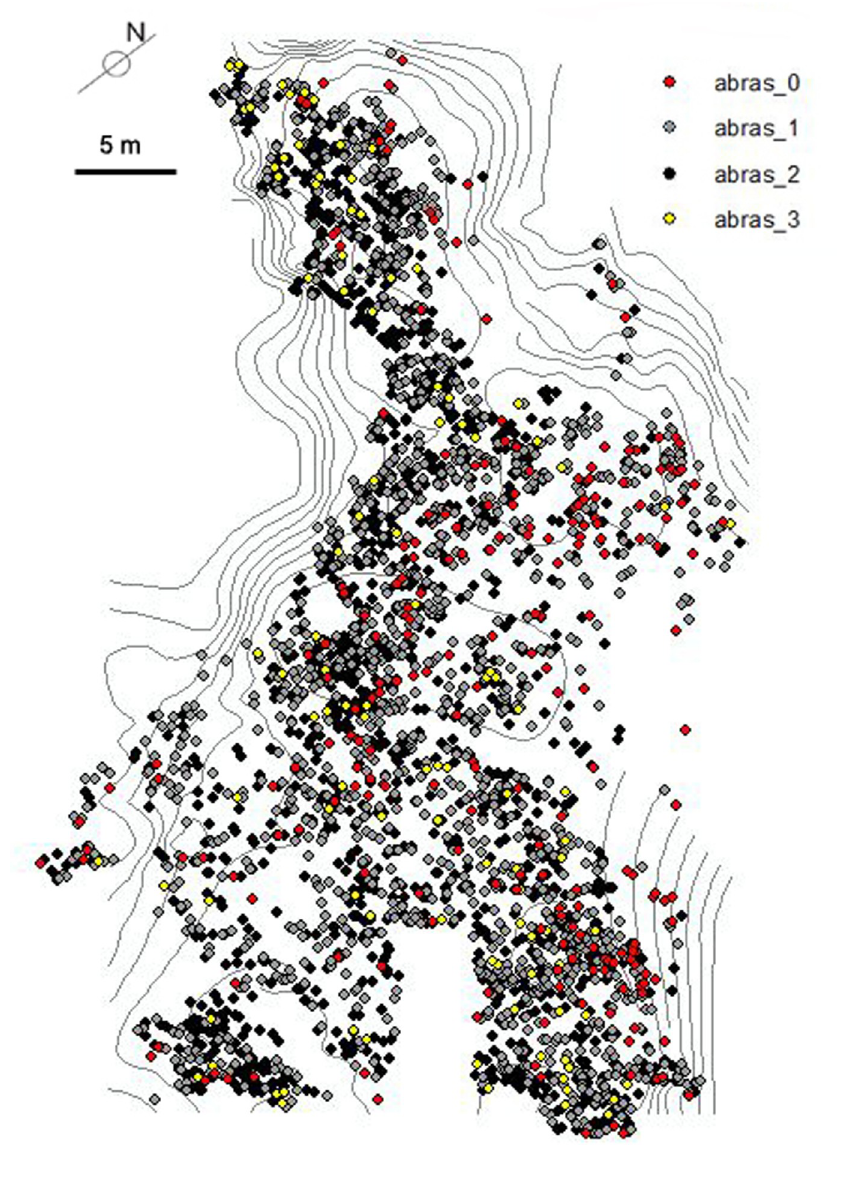
Fig 2. Plan of the castel di Guido excavation area with distribution of the faunal remains and contour map of the channel. Stages of abrasion are the same as those used in lithic analysis: 0 = fresh; 1 = slightly abraded; 2 = abraded; 3 = very abraded. The total N of specimens is 4037. Contour lines are at 20 cm. intervals. From [20: Fig 48].